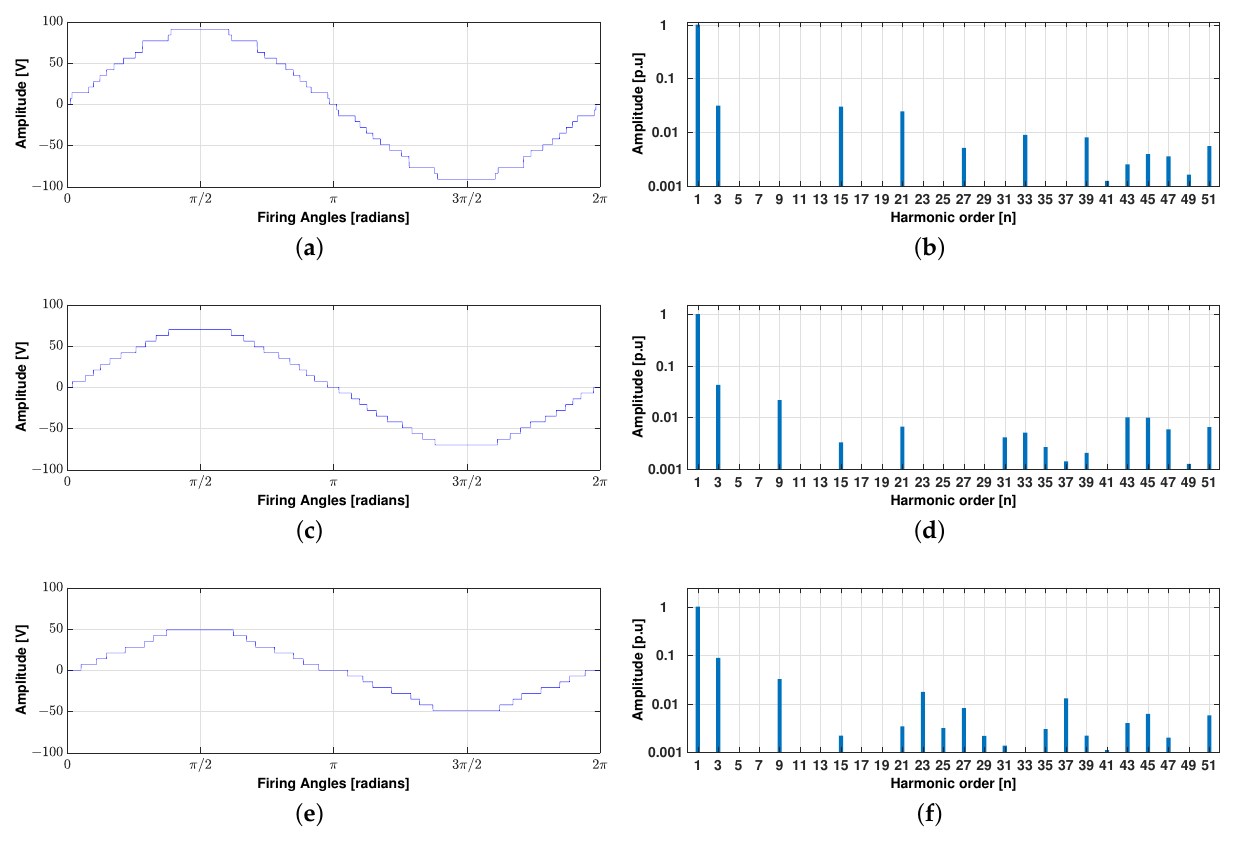
Figure 6. Waveforms: ( a ) Output voltage for M = 1.00, ( b ) voltage harmonic spectrum for M = 1, ( c ) output voltage for M = 0.75, ( d ) voltage harmonic spectrum for M = 0.75, ( e ) output voltage for M = 0.50, ( f ) voltage harmonic spectrum for M =